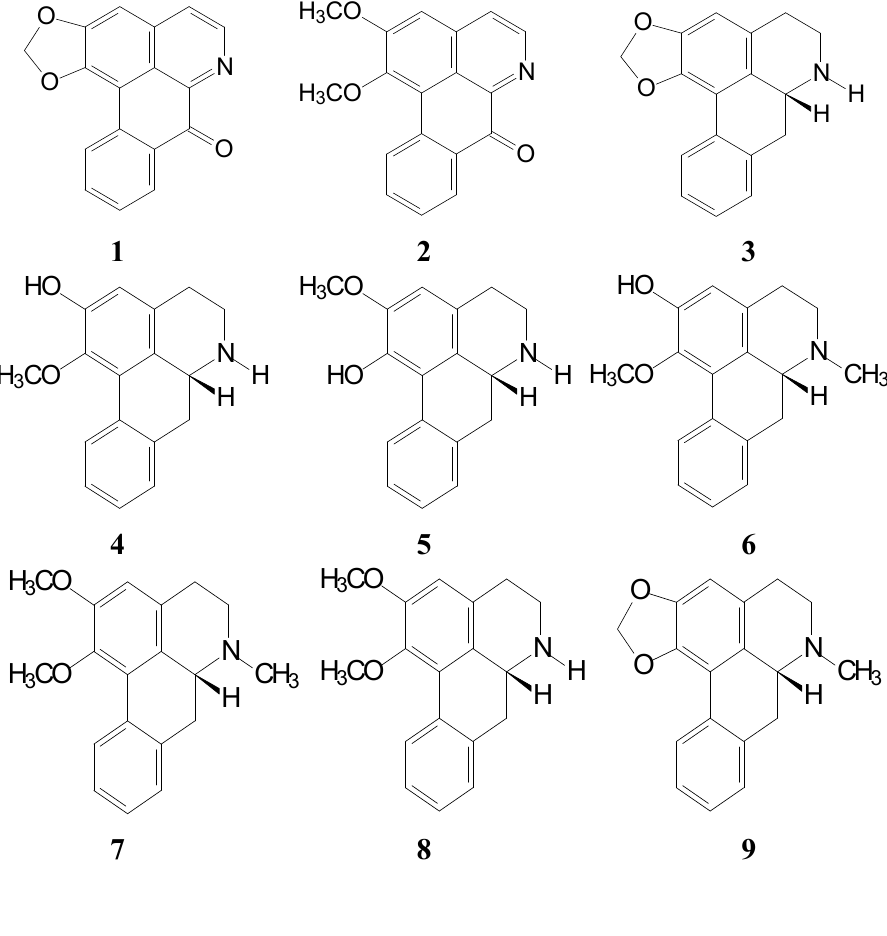
Figure 2. Structures of alkaloids ( 1 – 11 ) isolated from the leaves of N. nucifera